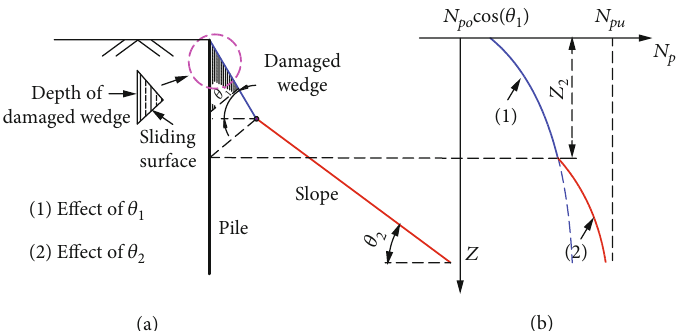
Figure 4: Ultimate soil resistance analytical model of the concave sloping ground. (a) Damaged wedge model of laterally loaded piles on the concave slope. (b) The N p curve along the pile on concave slope.